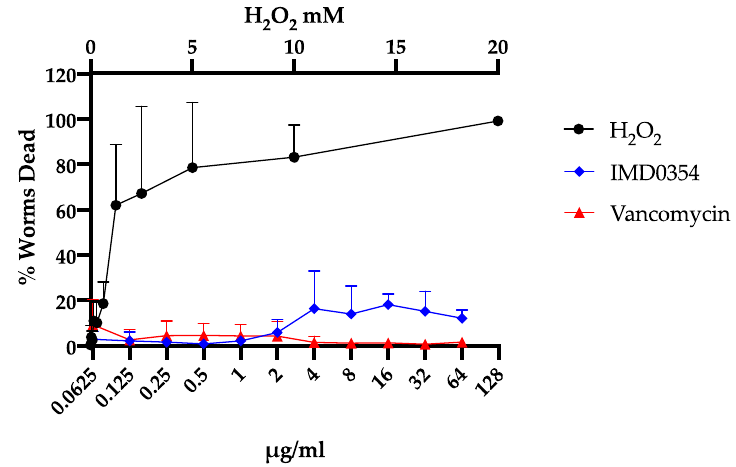
Figure 4. IMD0354 shows minimal toxicity toward C. elegans . Survival of C. elegans treated with various concentrations of IMD0354, normalized to C. elegans treated with DMSO. H 2 O 2 was used as positive control. ( n = 3, ± S.D). Bottom error bars are omitted for clarity.